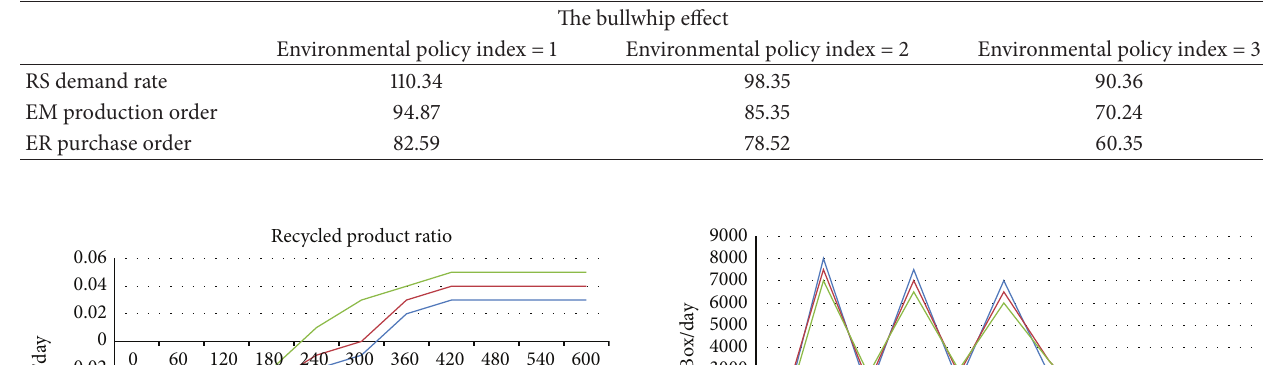
Table 2: The bullwhip effect in all members under different environmental policy index.